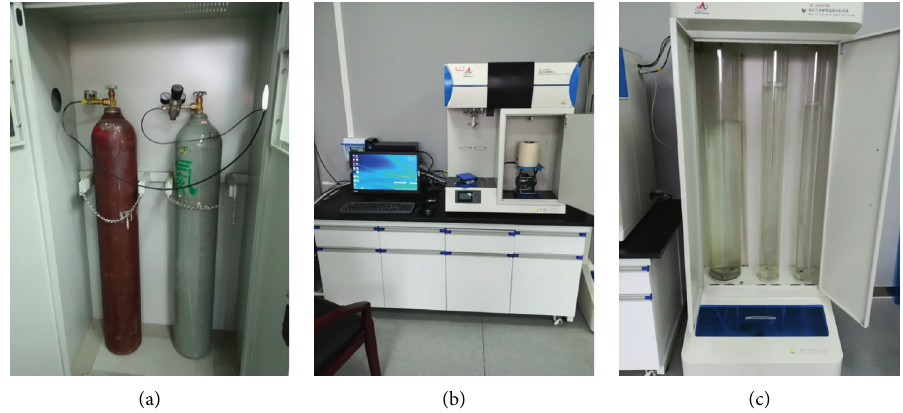
Figure 8: 3H-2000PH high-pressure gas adsorption and desorption instrument.